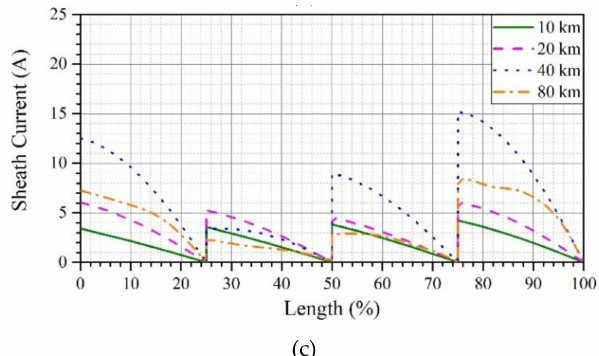
Figure 14. Steady state sheath circulating currents along length of 10, 20, 40 & 80 km cable ( a ) Single Point Grounded (SPG). ( b ) Multiple Single Point Grounded (MSPG—2 segments) ( c ) Multiple Single Point Grounded (MSPG—4 segments). Table 4. Sheath Losses (in joules / km) According to Sheath Grounding Scheme and Length of the Cable.